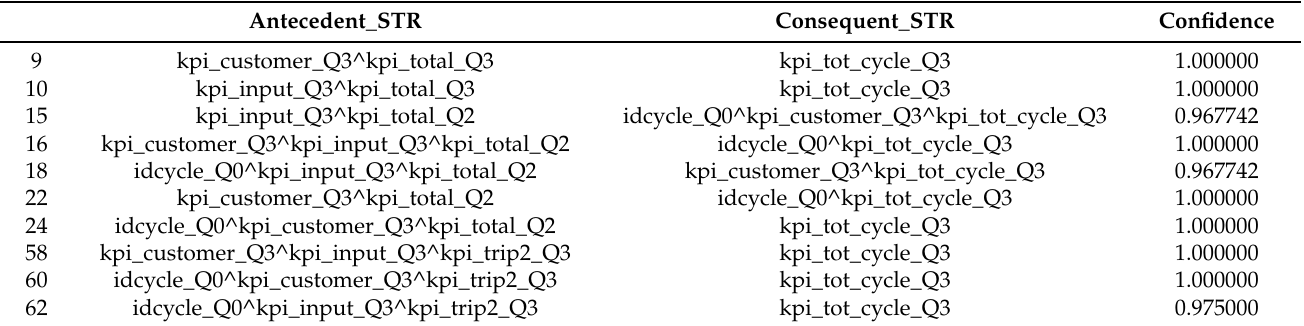
Table 4. Rules explaining the Q3 for the kpi_tot_cycle, where ^means logical and .